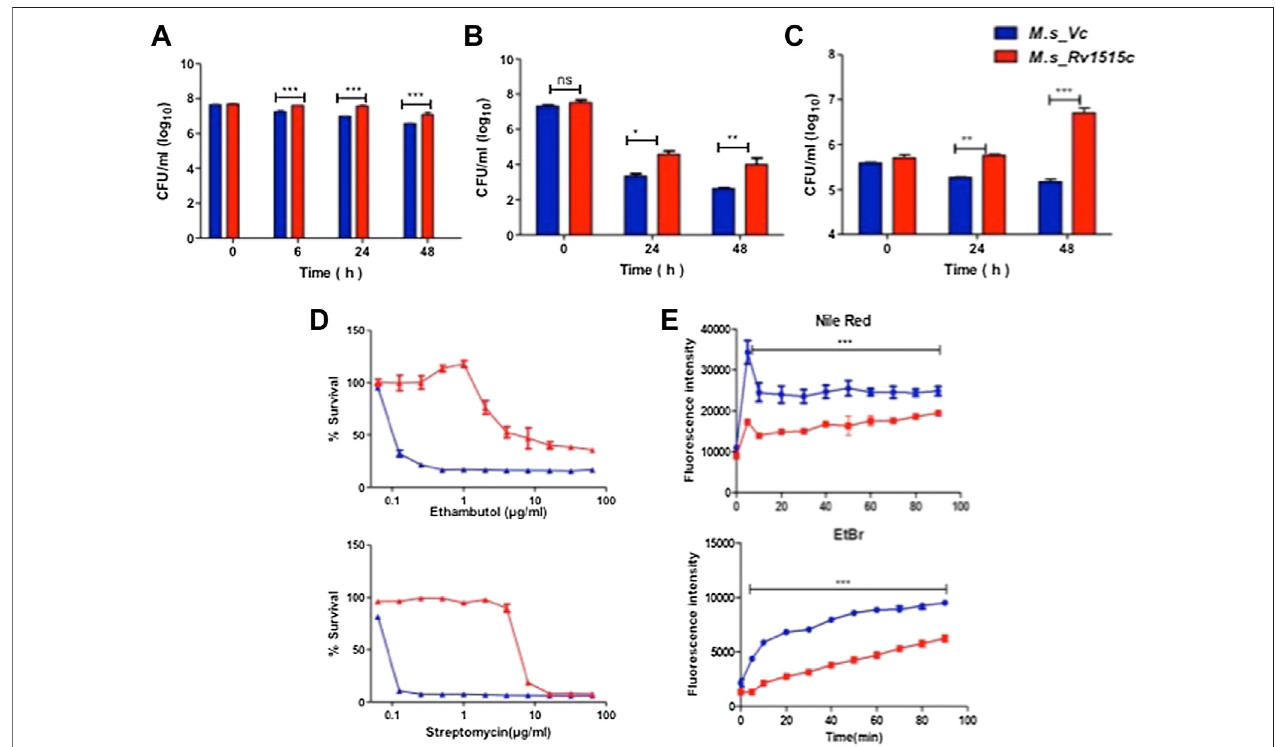
FIGURE 3 | Recombinant M. smegmatis expressing M. tb Rv1515c displayed greater resistance to various stress conditions and altered cell wall permeability. Growth of M. s _Vc and M. s _Rv1515c in presence of (A) 0.1% SDS; (B) 500 μ g/ml Lysozyme; (C) at pH 5; and (D) serial dilutions of anti-TB drugs Ethambutol and Streptomycin were estimated. (E) Uptake of Nile red (20 μ M) and Ethidium Bromide (2 μ g/ml) by M. s _Vc and M. s _Rv1515c cells for evaluating cell permeability. Data are represented as mean ± SD from three independent experiments. Statistical analysis was performed using two-way ANOVA followed by Bonferroni test. ** p < 0.01, *** p <